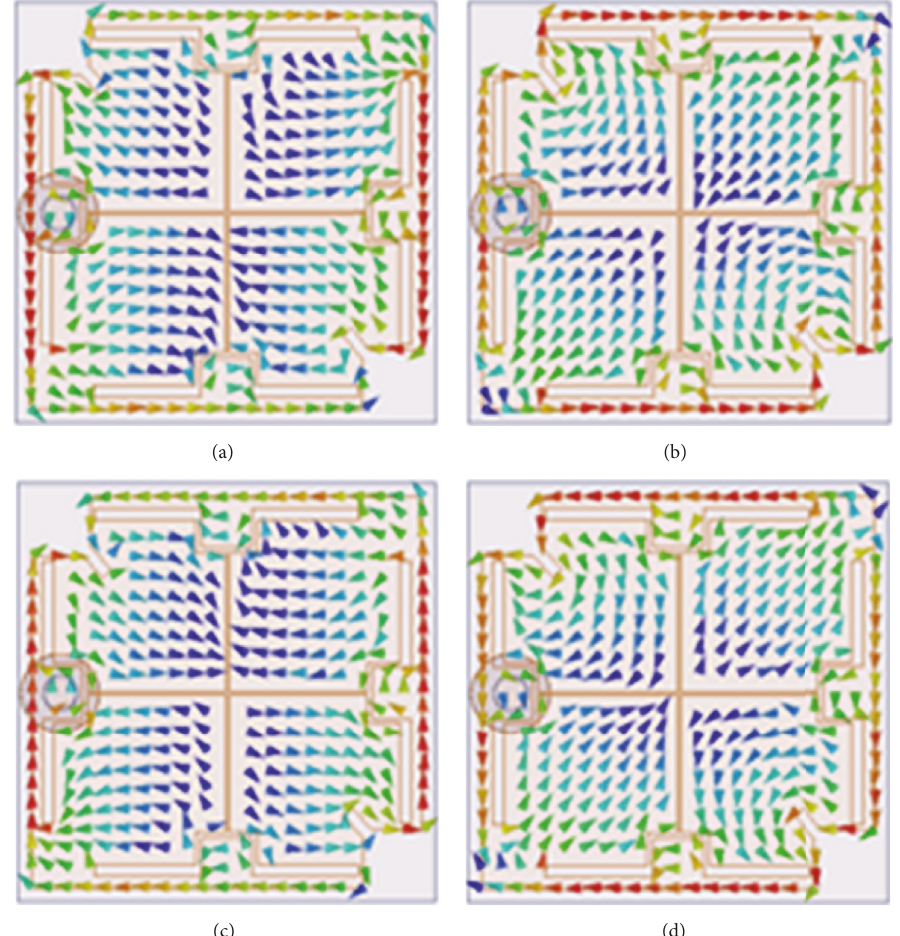
Figure 10: The current distribution of the proposed antenna at 915 MHz: (a) 𝑡 = 0 ; (b) 𝑡 = 𝑇/4 ; (c) 𝑡 = 𝑇/2 ; (d) 𝑡 = 3𝑇/4 .